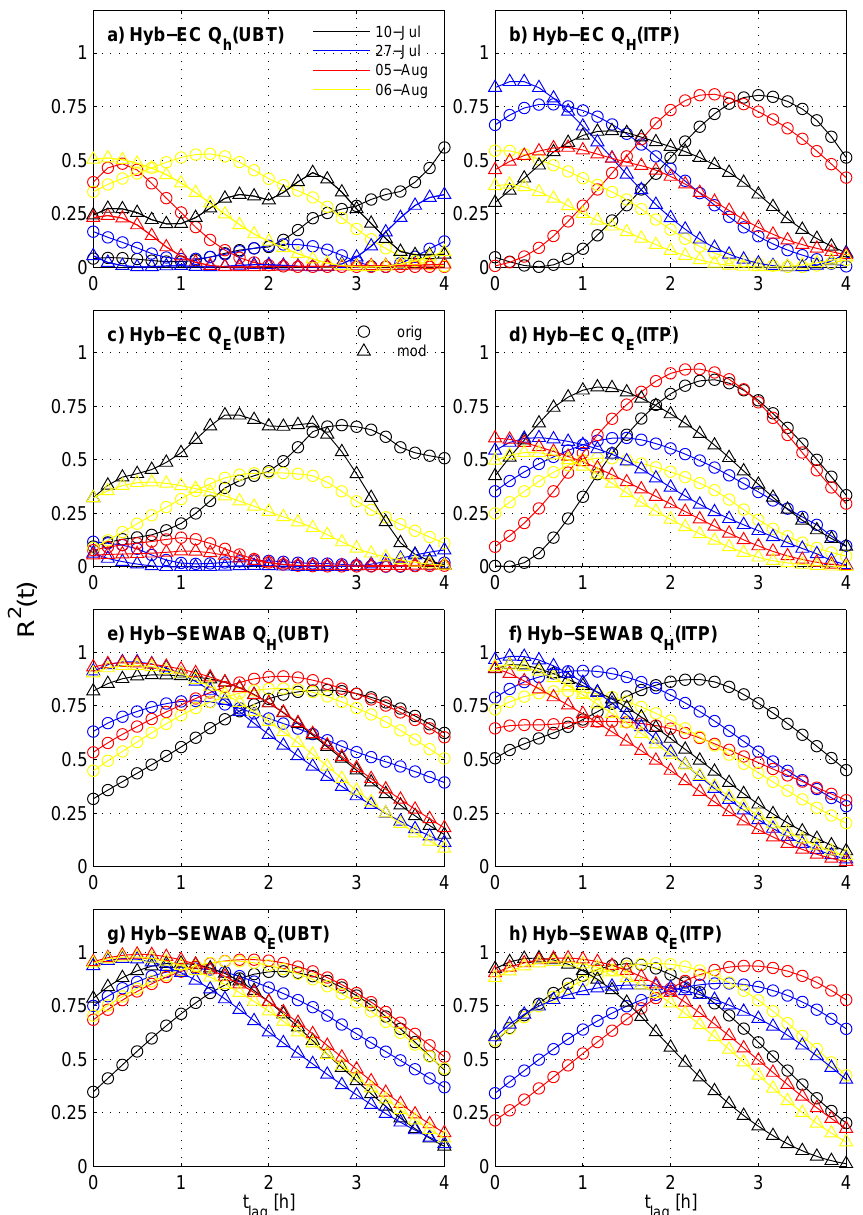
Fig. 8. Cross correlation R 2 (t) of simulated fluxes against flux reference shifted by t lag as multiples of 10 minutes for each of the four days simulated with the original and modyfied Hybrid. The maximum number of elements used in the calculation of R 2 for each curve can be taken from Table